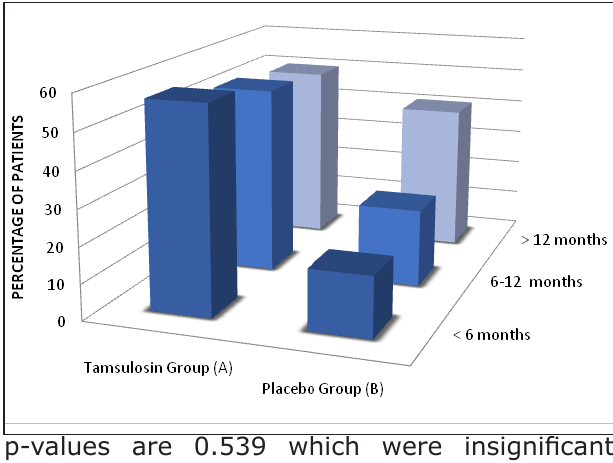
Figure-II: Stratification of patients according to the duration of BPH